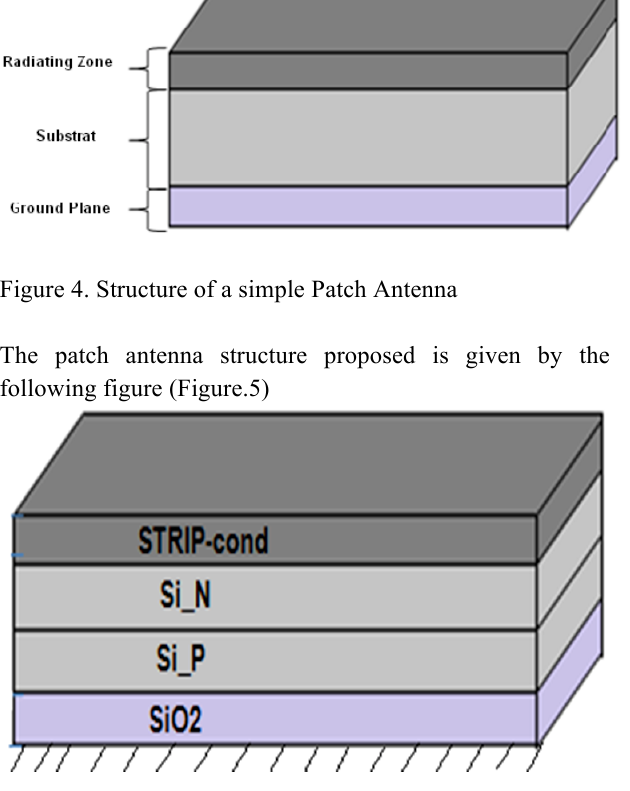
Figure5. Structure of a Patch Antenna based on a Solar Cell From an RF point of view, attention should be given to the bottom metal contact of the cell, which is homogeneous in structure so that the cell can be used as a suspended RF stacked parasitic patch element in addition to its photovoltaic function (DC power generation). This